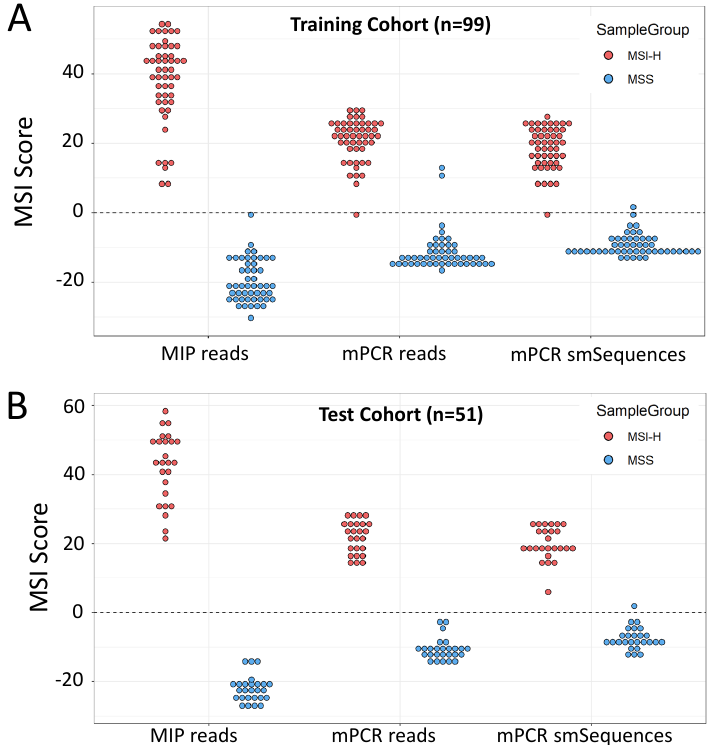
Figure 2. Training and validation of 12-marker mPCR assay. ( A ). Self-classification of training cohort ( n = 99) using the 24-marker MIP and 12-marker mPCR panels. MIP amplification of the 24-marker panel is included as the gold standard comparator ( B ). MSI scores in the test cohort ( n = 51) using classifiers trained on reads from the amplification method and read groups indicated. Scores >0 are classified as MSI-H, scores <0 as MSS.